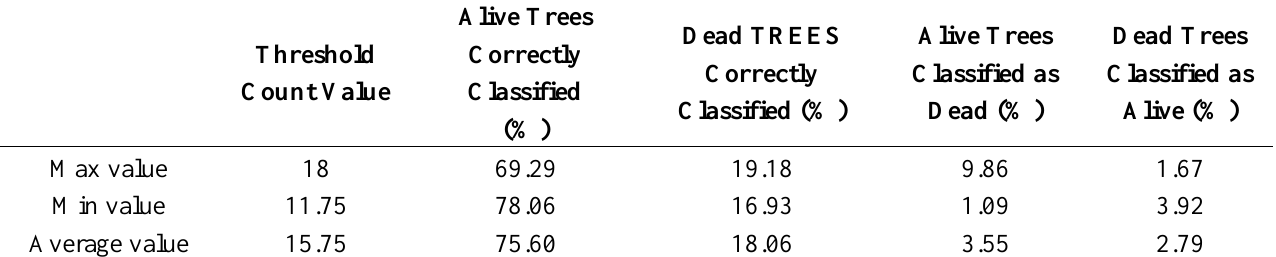
Table 3. Mean percentages of successful classifications and false positives and negatives during the calibration test with a dead range value of 55 at the different threshold count